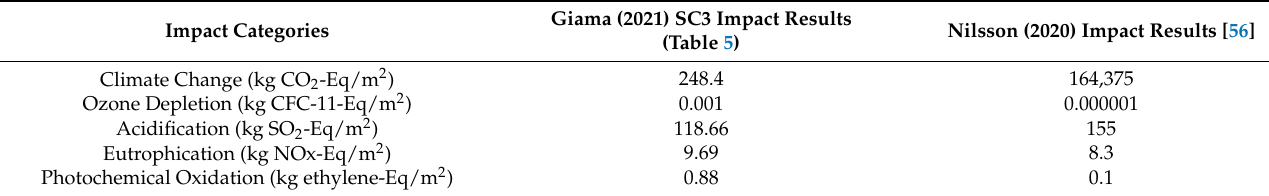
Table 4. Environmental impact assessment results validation for ventilation system applications in